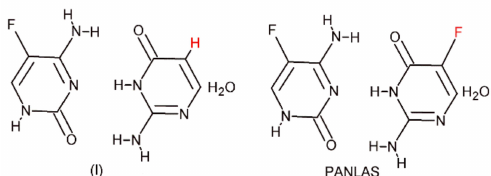
Scheme 2. Chemical components of the isomorphic and isostructural co-crystals of 5-fluorocytosine / isocytosine monohydrate, (I), and 5-fluorocytosine / 5-fluoroisocytosine monohydrate,